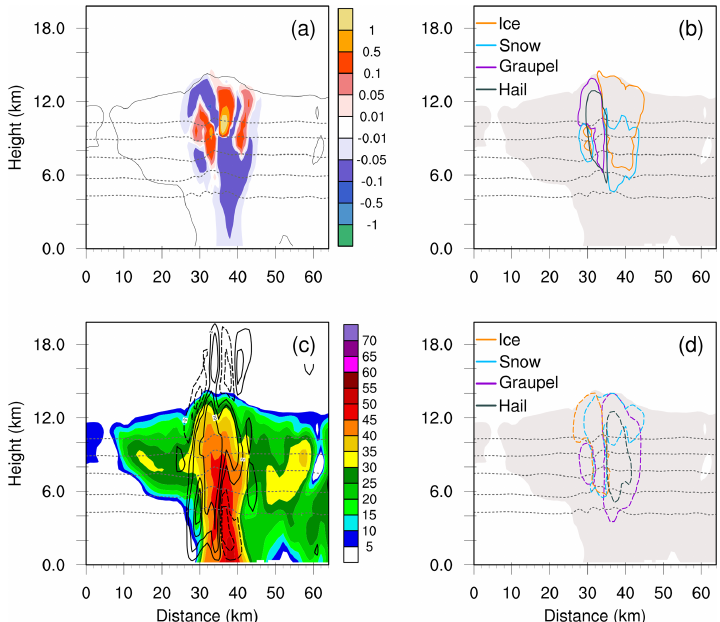
Figure 14. Vertical cross sections (south to north) at the location shown in Fig. 4f of simulated variables at the mature stage of the thunder- storm (11:54UTC) in the P case. (a) Total net space charge (nCm − 3 , shaded). The 0, − 10, − 20, − 30 and − 40 ◦ C isotherms are shown by dashed gray lines in (a) – (d) . (b) The + 0.1nCm − 3 space charge density contours for cloud ice (orange), snow (blue), graupel (purple) and hail (black). The cloud outline (reflectivity echoes ≥ 5dBZ) is denoted by the gray-shaded contour. (c) Radar reflectivity (unit dBZ), with black lines for vertical velocities (solid line: 2, 5, 10ms − 1 ; dashed line: − 2ms − 1 ). (d) As in (b) but for a − 0 . 1nCm − 3 charge density.